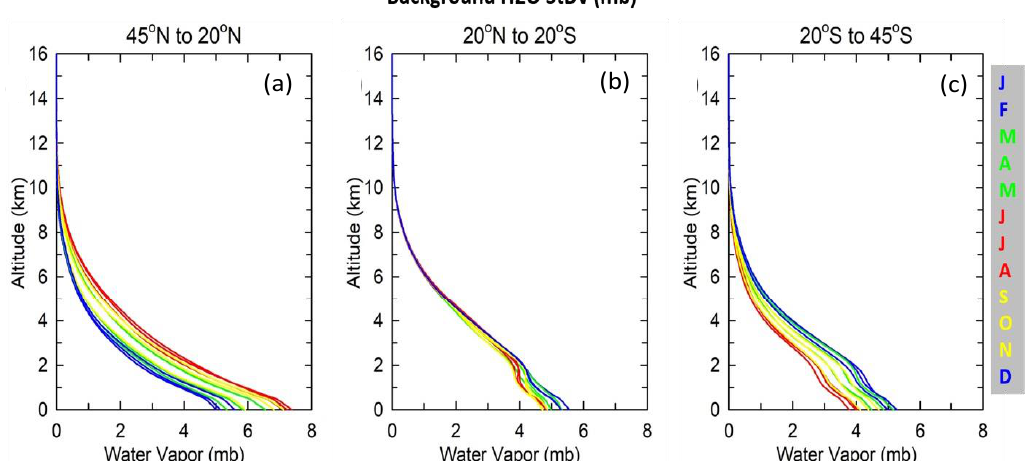
Figure 3. Background standard deviation of water vapor used in the optimal estimation: ( a ) northern mid-latitudes 45 ◦ N to 20 ◦ N, ( b ) tropics 20 ◦ N to 20 ◦ S, ( c ) southern mid-latitudes 20 ◦ S to 45 ◦ S. Each panel presents 12 months where blue lines (December, January, and February) are for northern winter, green lines are for northern spring (March, April, and May), red lines are for northern summer (June, July, and August), and yellow lines (September, October, and November) are for northern autumn.